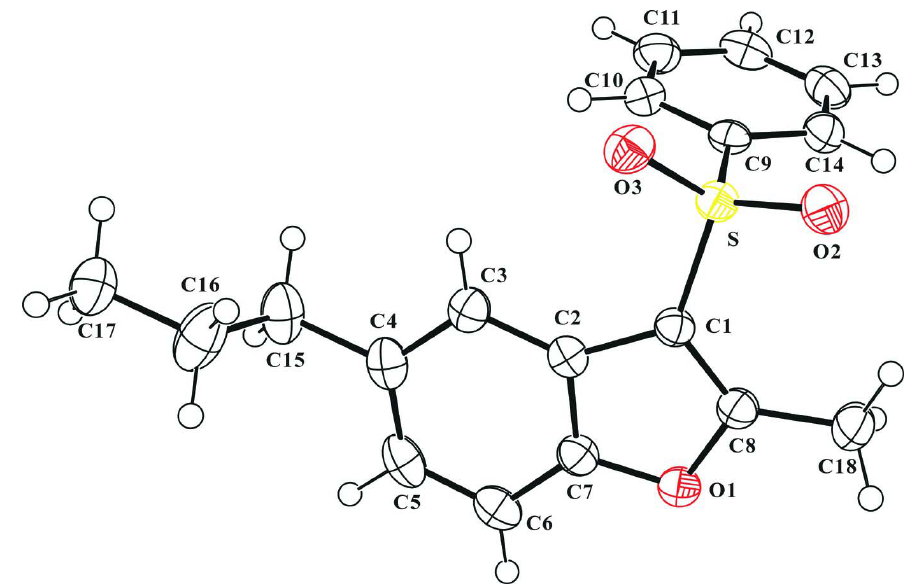
Figure 1 The molecular structure of the title compound, showing displacement ellipsoids drawn at the 50% probability level.